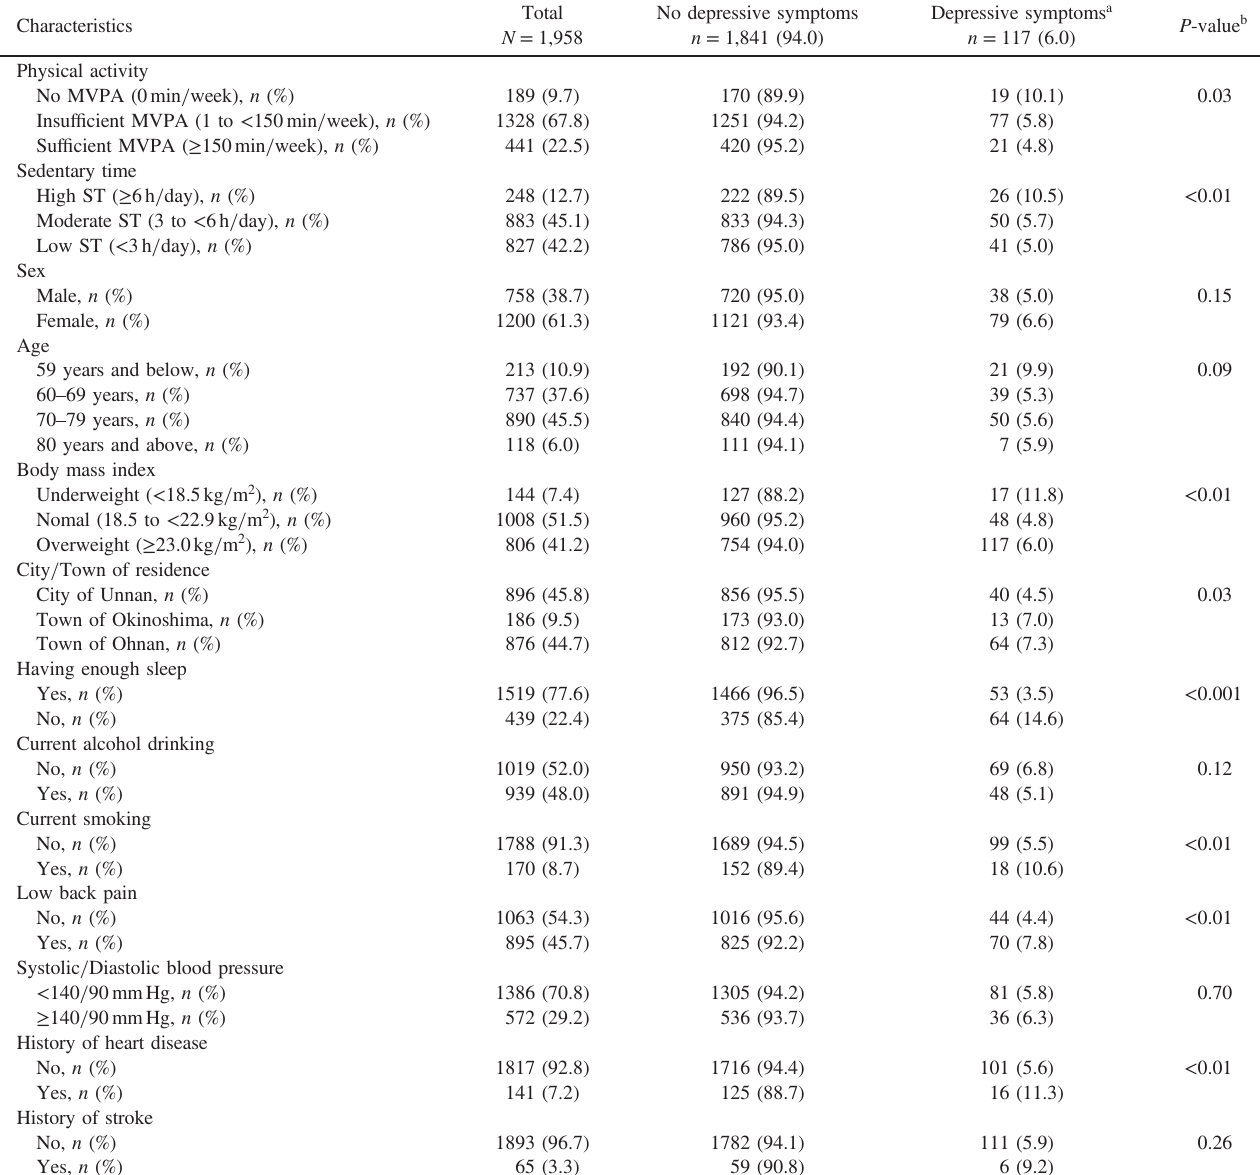
Table 1. Characteristics of study participants Characteristics